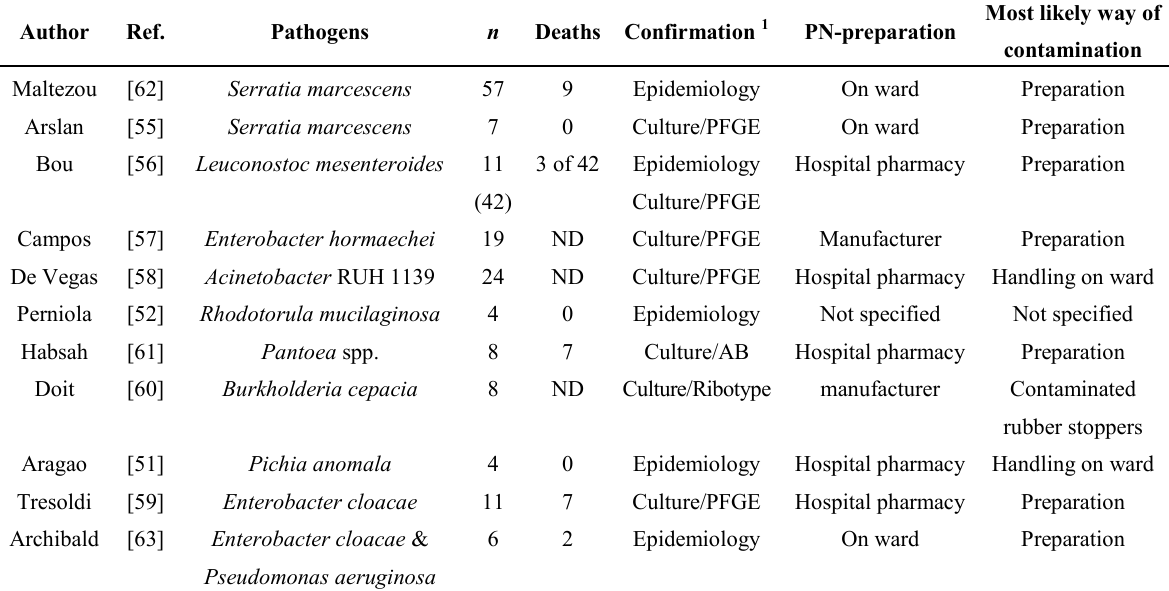
Table 1. Published outbreaks among neonates related to parenteral